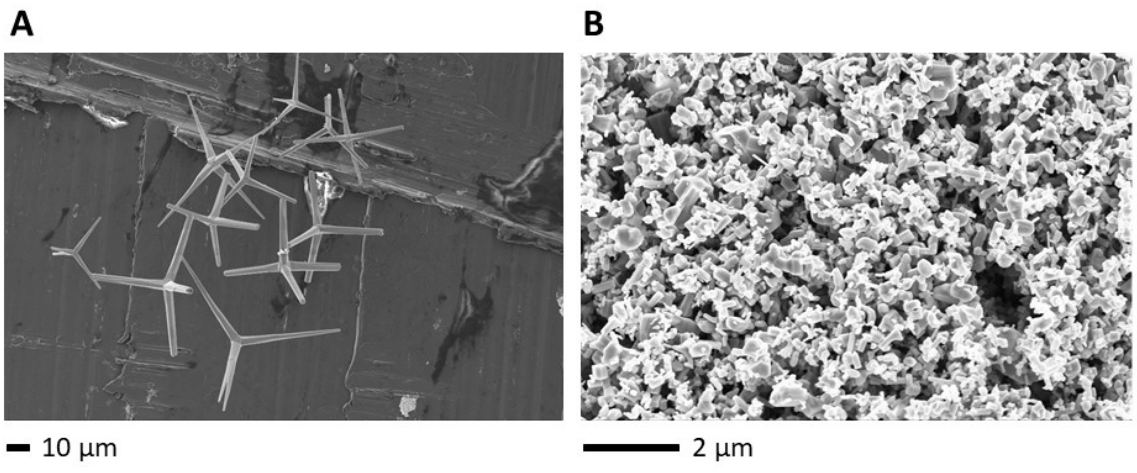
Figure 1. Electron micrographs of ( A ) ZnO tetrapods (t-ZnO) and ( B ) commercially available s-ZnO particles. s-ZnO particles are shown, which are supposed to be the major functional.